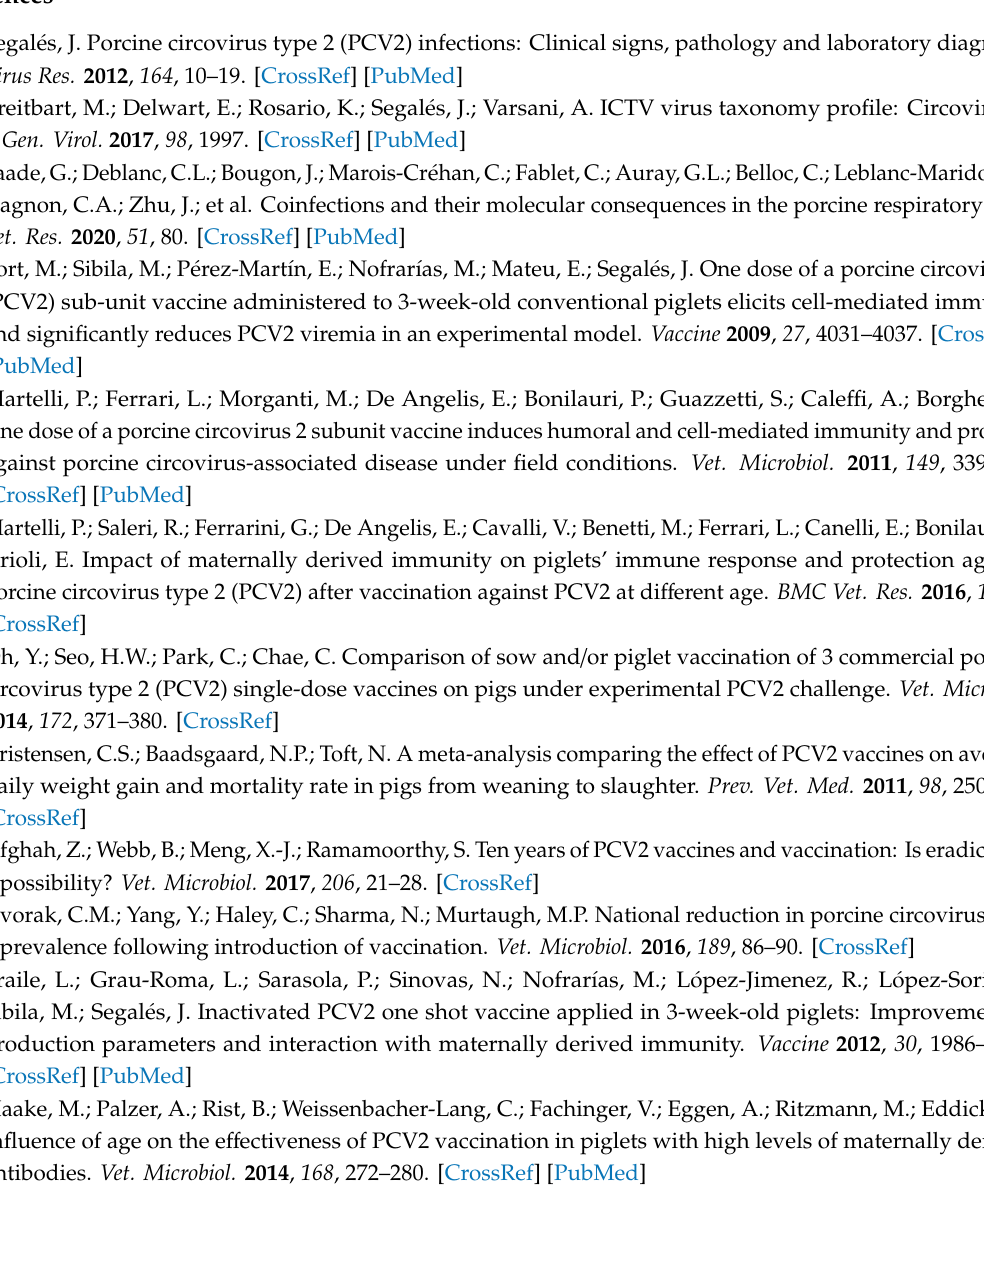
Table S1: Details of case numbers of each pig herd at di ff erent